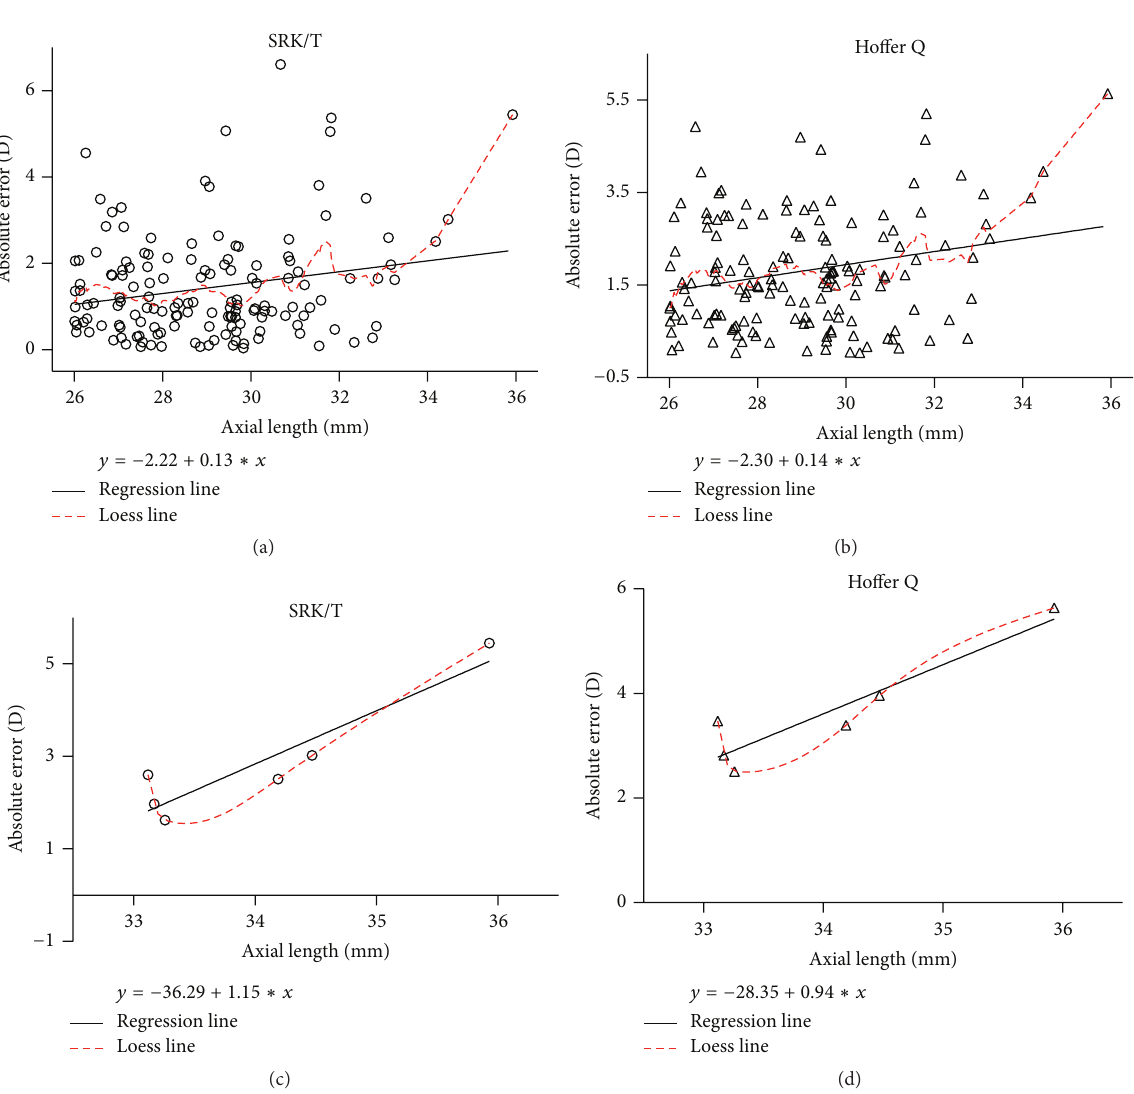
Figure 3: Correlations between axial length and absolute error. The associations between axial length and absolute error were analyzed using absolute errors derived from (a) the SRK/T formula ( 𝑟 = 0.212 ; 𝑃 = 0.010 ; regression equation: 𝑦 = −2.22 + 0.13𝑥 ) and (b) the Hoffer Q formula ( 𝑟 = 0.223 ; 𝑃 = 0.007 ; regression equation: 𝑦 = −2.30 + 0.14𝑥 ). Similar analyses were carried out with Group D data only using (c) the SRK/T formula ( 𝑟 = 0.926 ; 𝑃 = 0.008 ; regression equation: 𝑦 = −36.29 + 1.15𝑥 ) and (d) the Hoffer Q formula ( 𝑟 = 0.928 ; 𝑃 = 0.008 ; regression equation: 𝑦 = −28.35 + 0.94𝑥